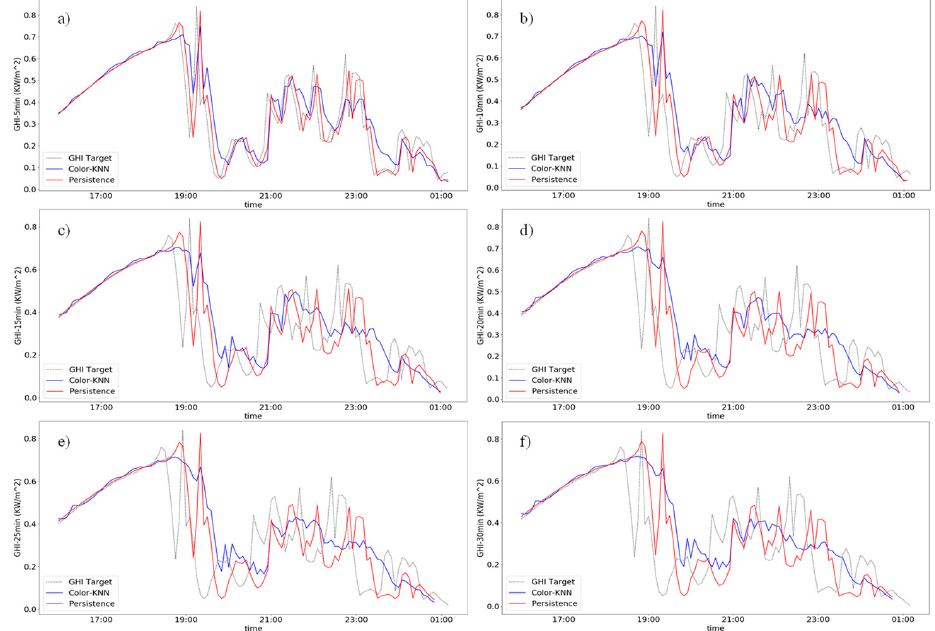
Figure 7. Forecasted GHI against target value of different methods. ( a ): 5 min; ( b ): 10 min; ( c ): 15 min; ( d ): 20 min; ( e ): 25 min; and ( f ): 30 min.